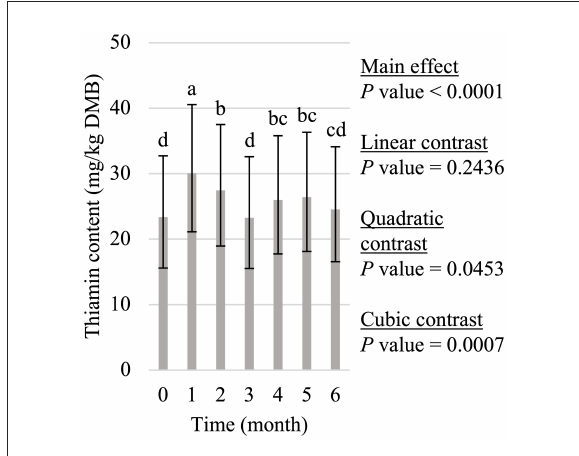
FIGURE3 Main effect of time on dry matter basis (DMB) thiamin content (average with 95% confidence interval) of canned cat food stored in a commercial warehouse for 6 months. a − d Means without a common superscript are different ( P < 0.05).